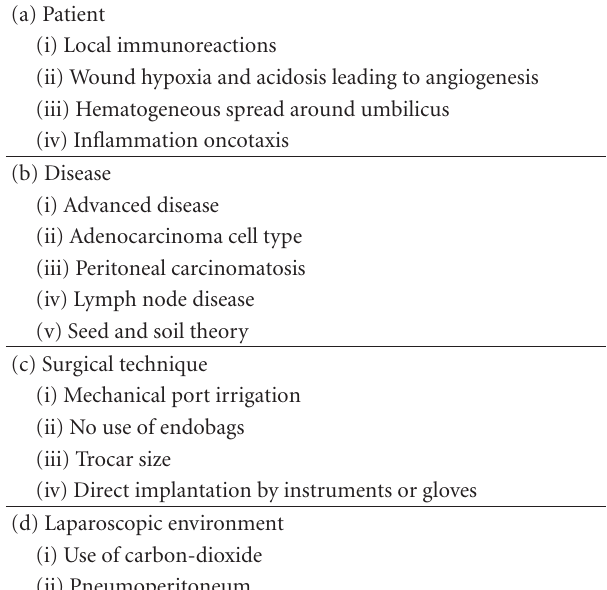
Table 2: Potential risk factors of abdominal